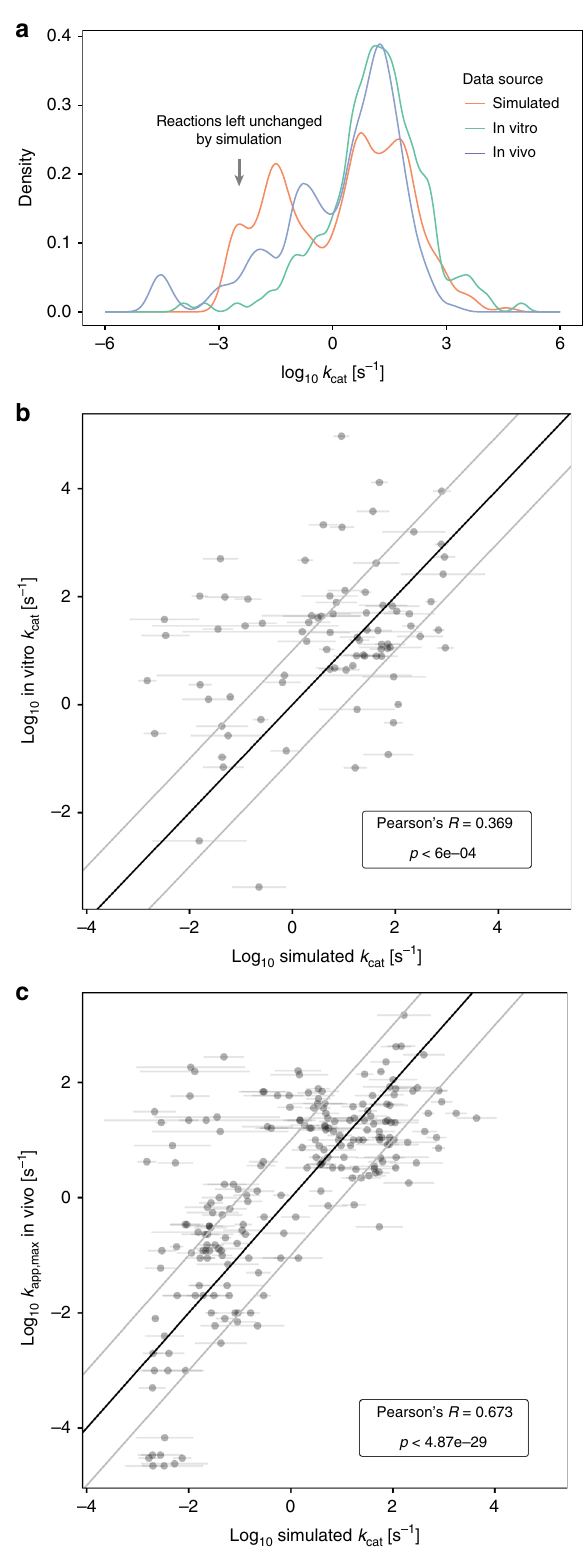
Fig. 4 Comparison between k cat predictions for evolution in diverse environments and experimental data. a Distribution of turnover rates in in vitro ( n = 188) 16 , in vivo ( n = 210) 39 , and simulated data ( n = 276). Simulated data are only shown for non-constrained reactions that contribute to growth. The arrow indicates reactions that were essentially left unchanged by the simulation, indicating that they were not used in most environments. b Comparison between experimental in vitro data and simulated data for reactions contributing to growth ( n = 83). c Comparison between experimental in vivo data ( k app,max ) and simulated data for reactions contributing to growth ( n = 210). The outliers in the upper left suggest that these reactions are rarely used in the environmental conditions that we model. Horizontal error bars in b and c show the